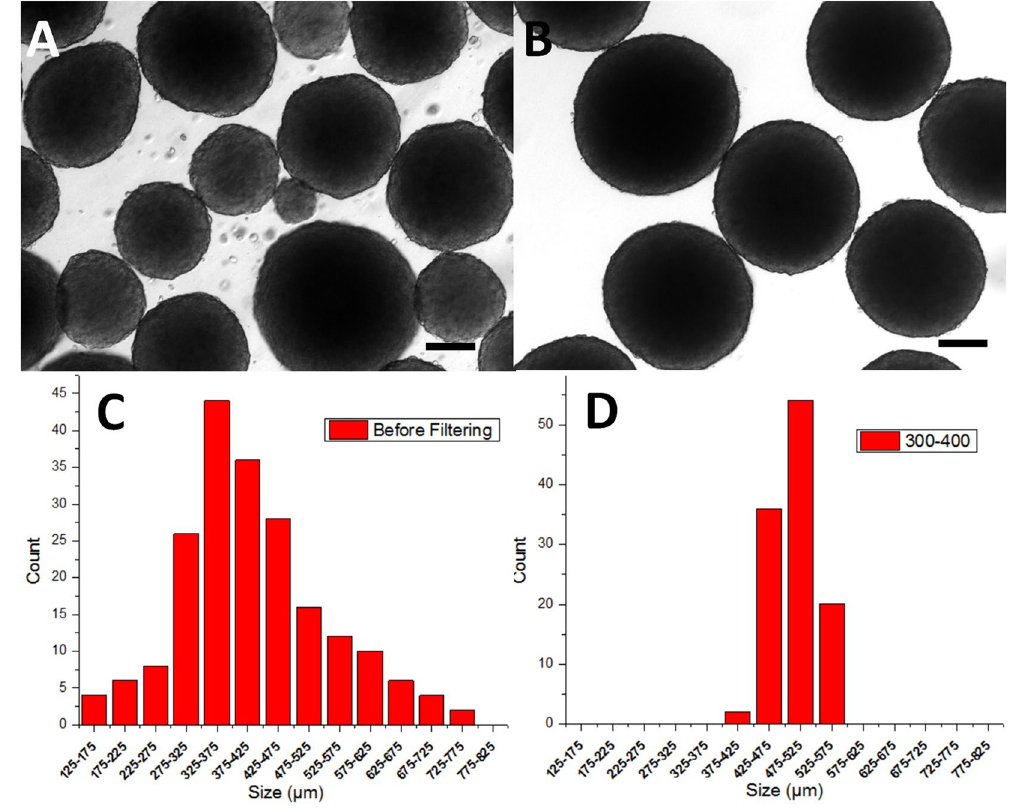
Figure 4. Tumor spheroids size uniformization. ( A ) A typical image showing the wide size-distribution of the tumor spheroids, taken at shaking day 7 (detached at sheet-growth day 9). Tumor spheroids from the same batch as ( A ) filtered from 300–400 µ m sieves ( B ). ( C and D ) Tumor spheroid size distribution before and after filtration, corresponding to ( A and B ). Each spheroid count was counted and calculated from 10–30 images taken at certain size distributions. All scale bars are 200 µ